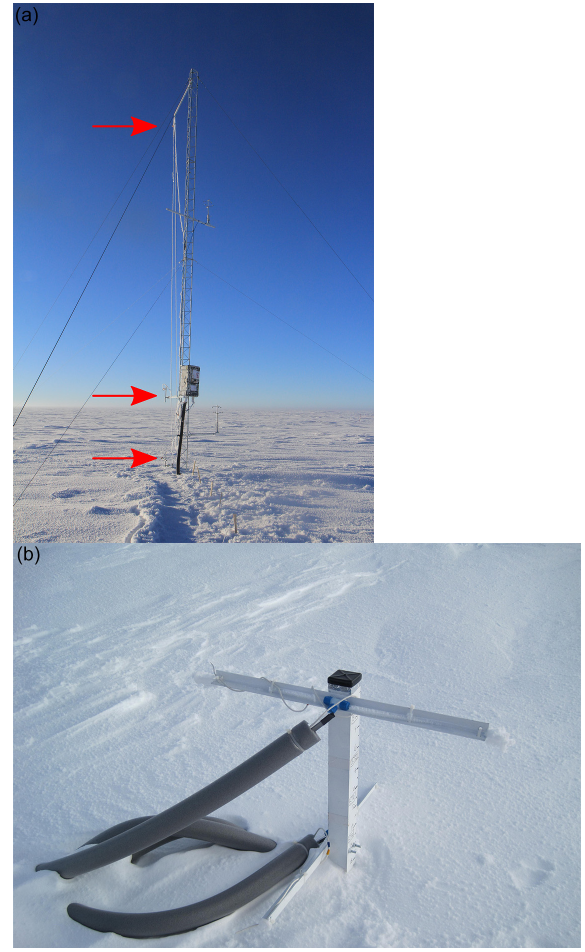
Figure 2. Photographs showing (a) the meteorological tower with the three gas inlets (red arrows) at 1070, 210 and 25cm above the snow surface (photo credit: B. Jourdain), and (b) one of the snow towers with the two sampling inlets above the snowpack at 50 and 10cm (photo credit: D.